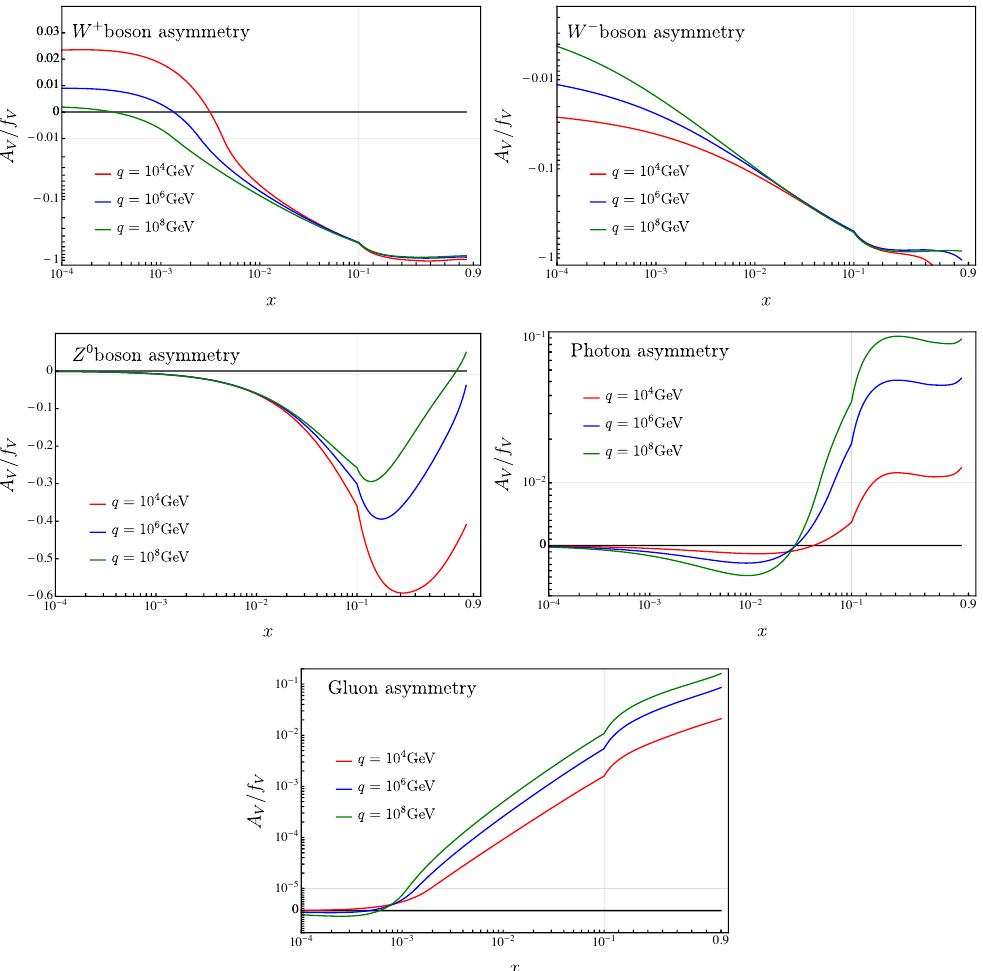
Figure 6 . Polarization of gauge bosons normalized to their unpolarized PDFs. The thin gray line shows where the scales on the x- and/or y-axes switch between linear and logarithmic.